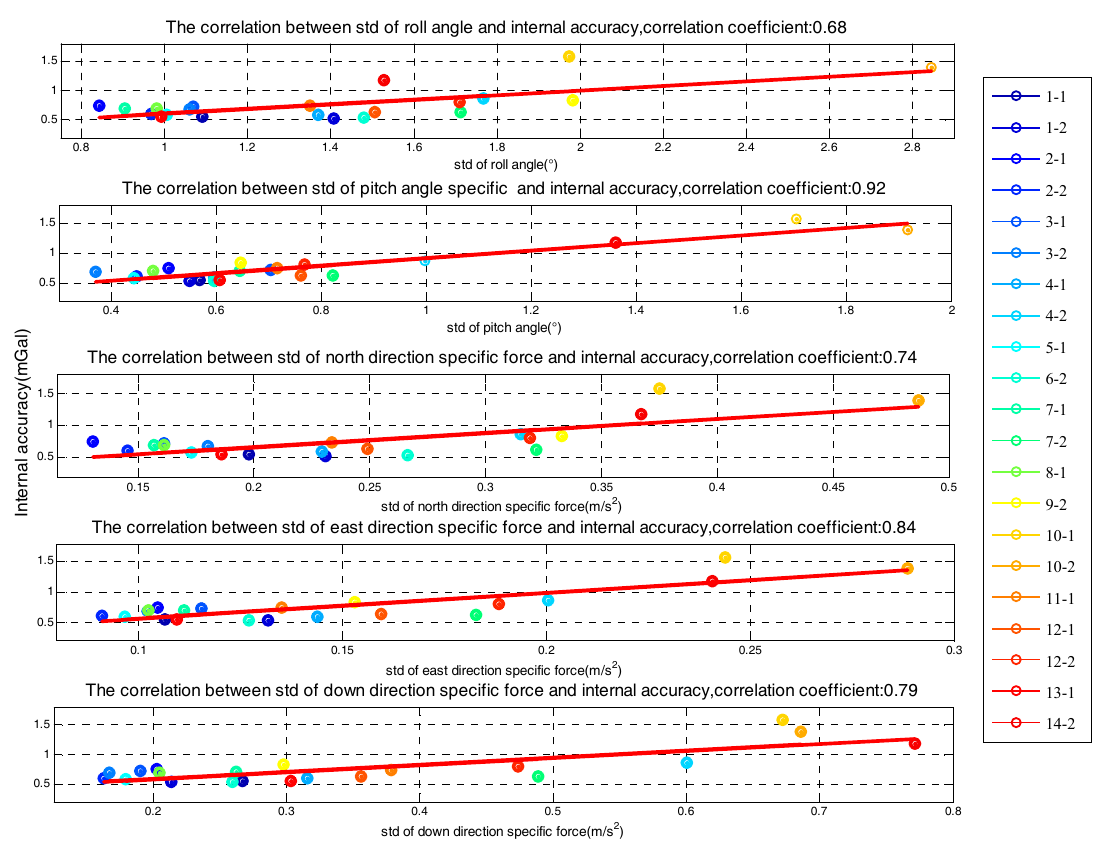
Figure 7. Correlation between determinants and internal root mean square error (RMSE).